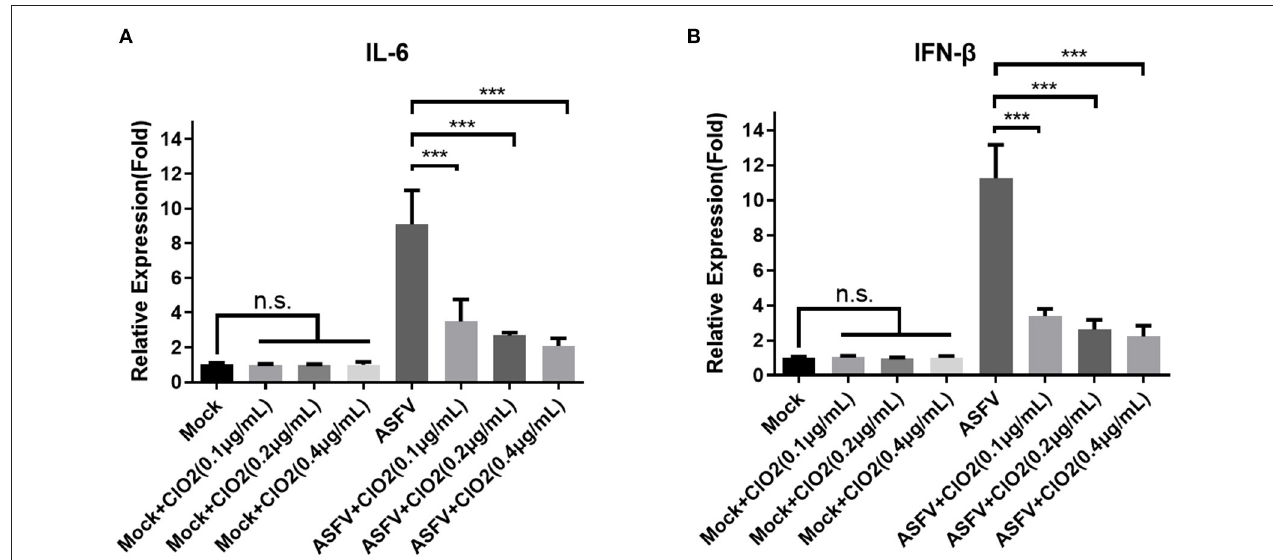
FIGURE 8 | Cytokines expression in PAMs treated with ClO 2. (A,B) PAMs were mock infected or infected with ASFV at an MOI of 1 in the presence of various concentrations of ClO 2 . After cultured for 6h, cells were lysed for the determination of the expression of IL-6 (A) and IFN- β (B) using qRT-PCR. Data are representative of the results of three independent experiments (means ± SE). Significant differences compared with control group are denoted by *** P <